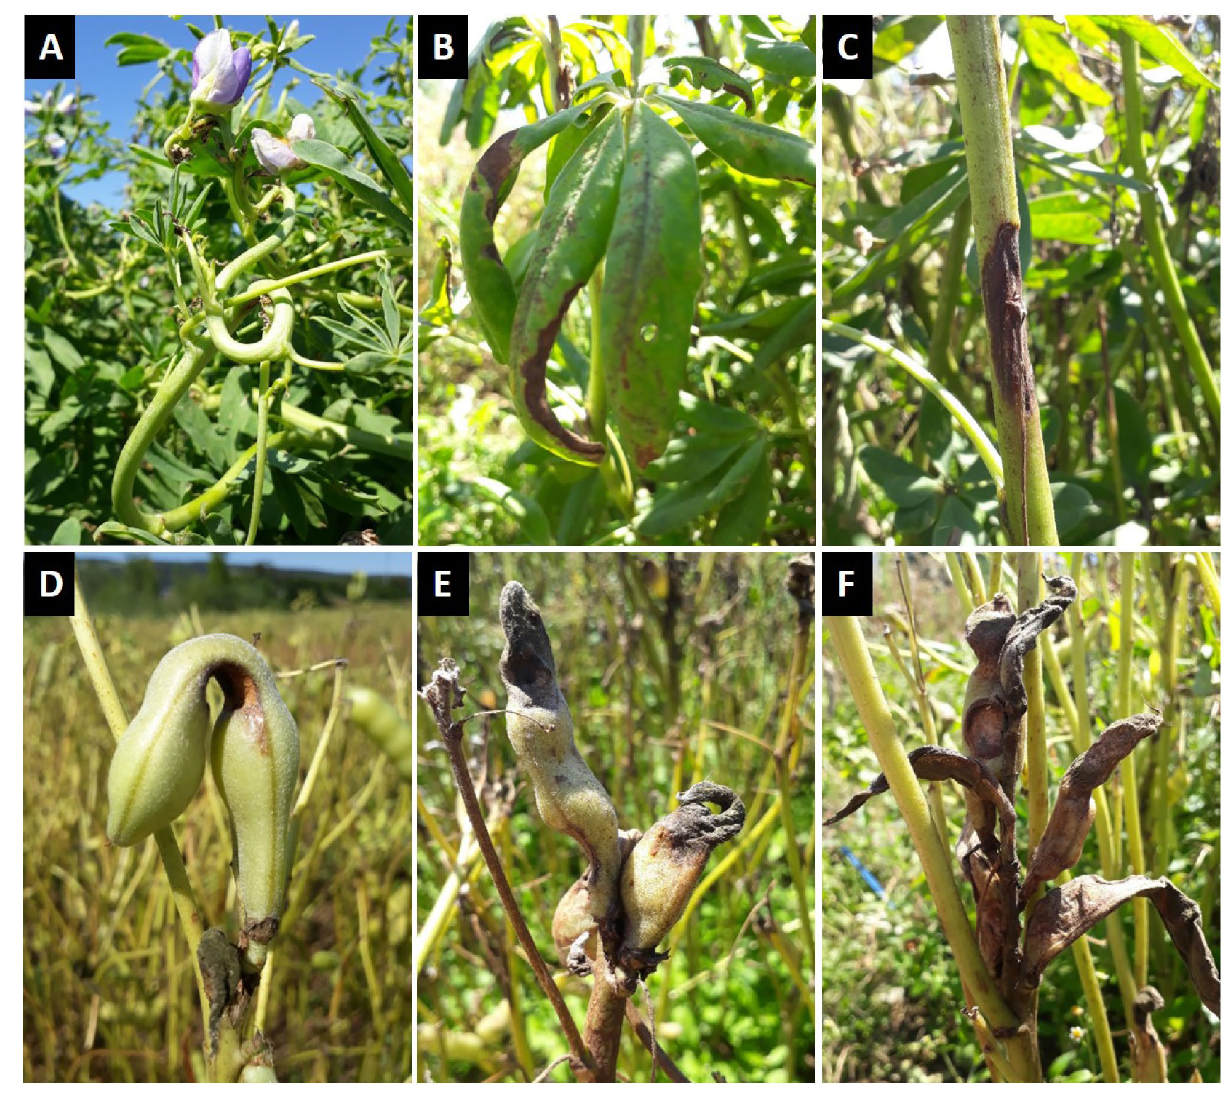
Figure 1. Symptoms on lupin tissue associated with Collletotrichum lupini . ( A ) typical stem twisting ( Lupinus mutabilis ); ( B ) on the leaves ( L. albus ); ( C ) on the main stem ( L. albus ); ( D – F ) on the pods ( L. albus ). Photos by Alkemade